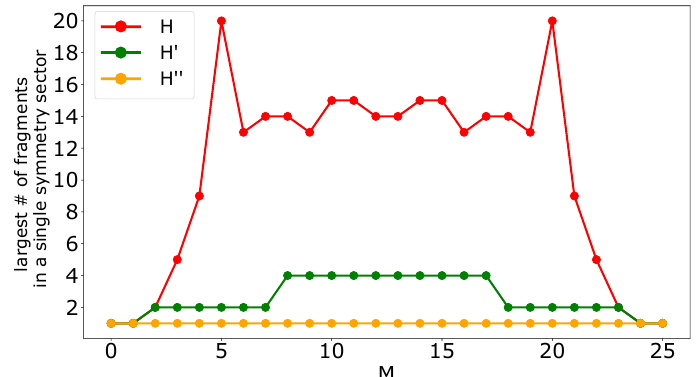
Figure 9: Lattice 5 × 5 with p.b.c.; The largest number of fragments in a single sym- metry sector for each M -sector.